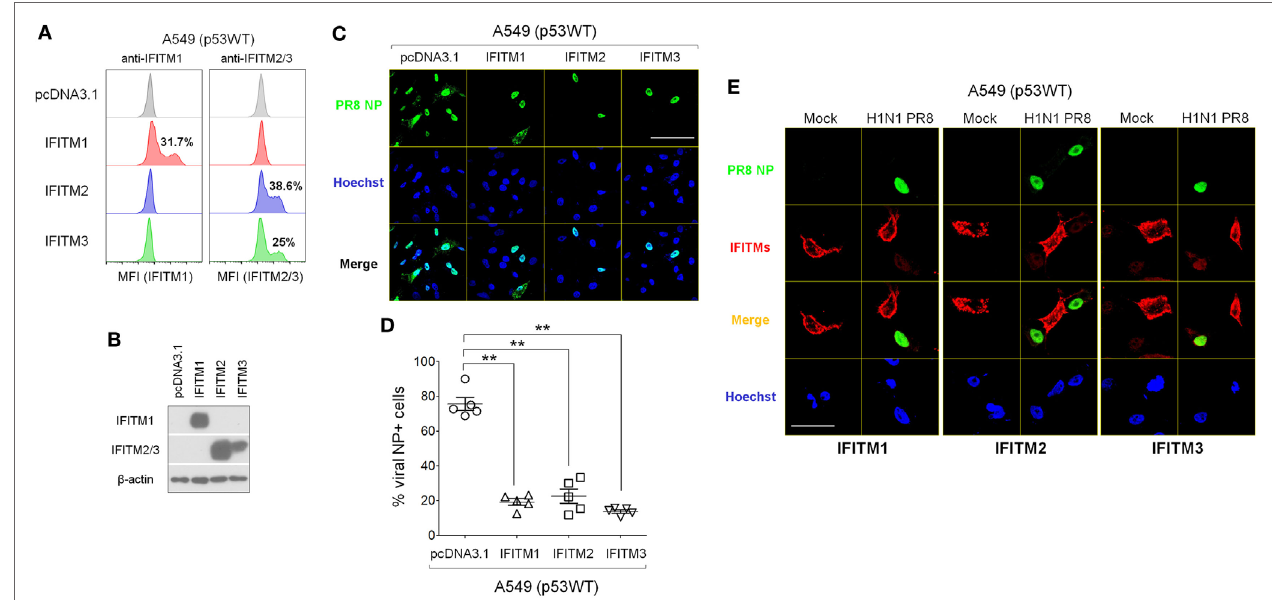
FigUre 7 | Overexpressed interferon-induced transmembrane proteins (IFITMs) reduce cellular susceptibility to IAV infection. Mammalian expression plasmids encoding human IFITM1, IFITM2, or IFITM3 were constructed and transfected individually into p53WT A549 cells. After 24 h, cells were detached using trypsin and re-plated onto cell culture plates or μ -slides and after overnight culture, cells were infected with IAV (multiplicity of infection = 0.001) or mock control. At 24 h post-infection, cells were harvested for different assays and protein lysates were also collected. (a) Transfection efficiency was measured by flow cytometry analysis using IFIMT1- or IFITM2/3-specific antibodies. (B) Overexpression of IFITMs in transfected A549 cell cultures was detected by Western blot. (c) Representative immunofluorescence microscopy images of IAV-infected A549 cell cultures after transfection with IFITM1, IFITM2, or IFITM3 expression plasmids. IAV nucleoprotein (NP) is shown in green, and Hoechst 33342-stained nuclei in blue. Scale bar, 50 µm. (D) Percentage of NP-positive cells in IAV-infected A549 cell cultures that overexpressed IFITM1, IFITM2, or IFITM3 proteins, quantified from fluorescence microscopy images. Five areas were randomly selected for image capture and the percentages of NP-positive cells (green) were calculated relative to the total cell numbers, reflected by Hoechst staining (blue). ** p < 0.01. (e) Immunofluorescence microscopy images of IAV-infected A549 cells transfected with IFITM1, IFITM2, or IFITM3 expression plasmids. IFITMs are shown in red, IAV NP in green, and Hoechst 33342-stained nuclei in blue. Scale bar: 20